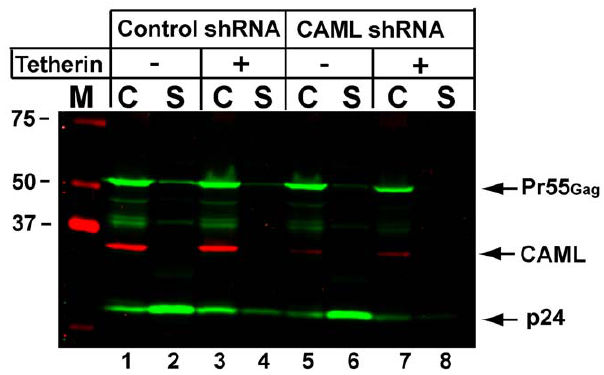
Figure 2. CAML depletion does not inhibit tetherin-mediated restriction of particle release. 293T cells were transduced with an shRNA-encoding lentivirus expressing control shRNA or CAML shRNA and selected with puromycin. Selected cell populations were then transfected with tetherin expression vector and NLUdel proviral DNA. Cells (C) and supernatants (S) harvested at 48 hours for Western blot analysis. Particles present in supernatants were pelleted through 20% sucrose prior to loading. Analysis was performed using infrared detection, allowing simultaneous assessment of CAML in cell lysates by rabbit polyclonal antisera (red) and HIV Gag proteins by anti-p24 monoclonal antibody (green). Co-transfection of cells with a tetherin expression construct is indicated by plus signs. M = molecular mass markers.